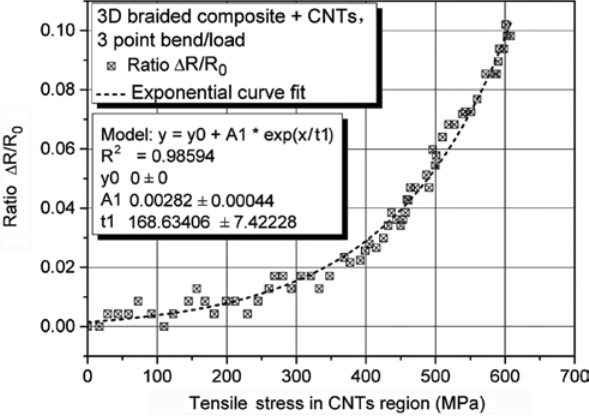
Figure 8: The relationship of mechanical stress and Δ R / R